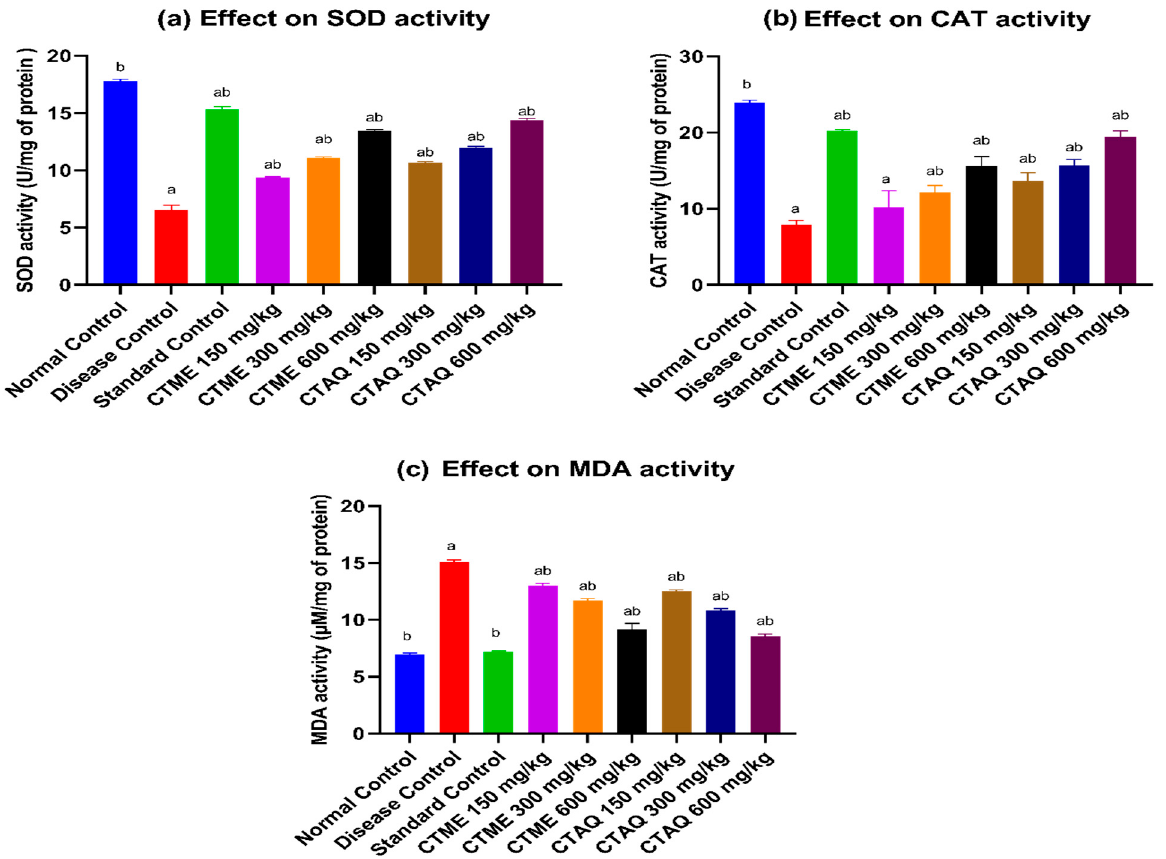
Figure 9. Effect of C. tuberculata on antioxidant level after CFA-induced arthritis. Values as mean ± S.D ( n = 6). Results were significant ( p < 0.001–0.0001) as equated to a and b. Where a: NCG; b: